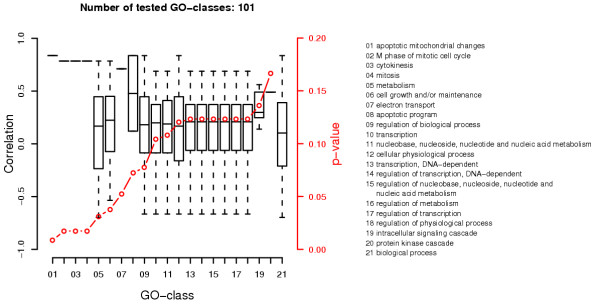
Correlations and p-values of the expression dataset from Zhang. Analogous to figure 3